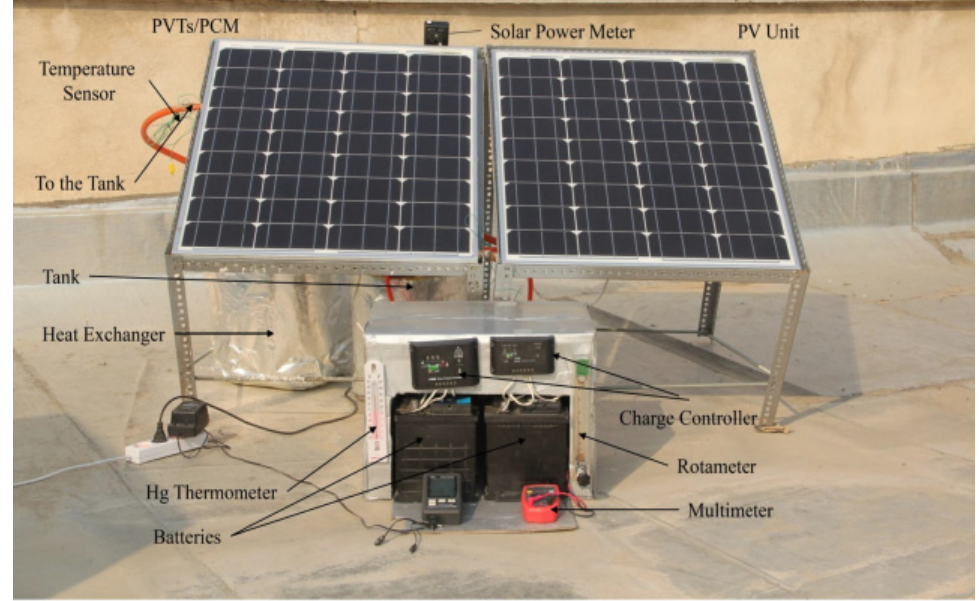
Figure 18. Photograph of the experimental facility studied by Naghdbishi et al. [62]. Adapted with permission from Elsevier.